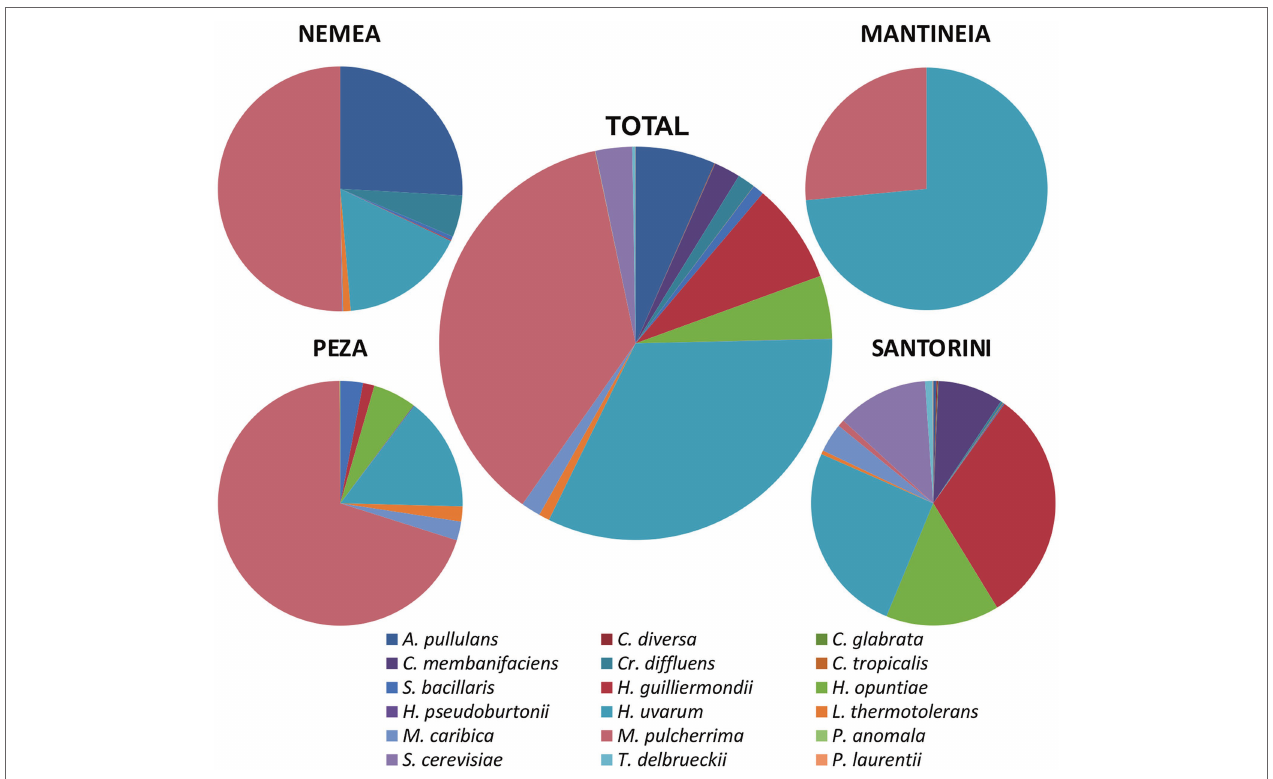
FIGURE 2 | Species diversity and relative abundance of yeasts in different winegrowing regions.